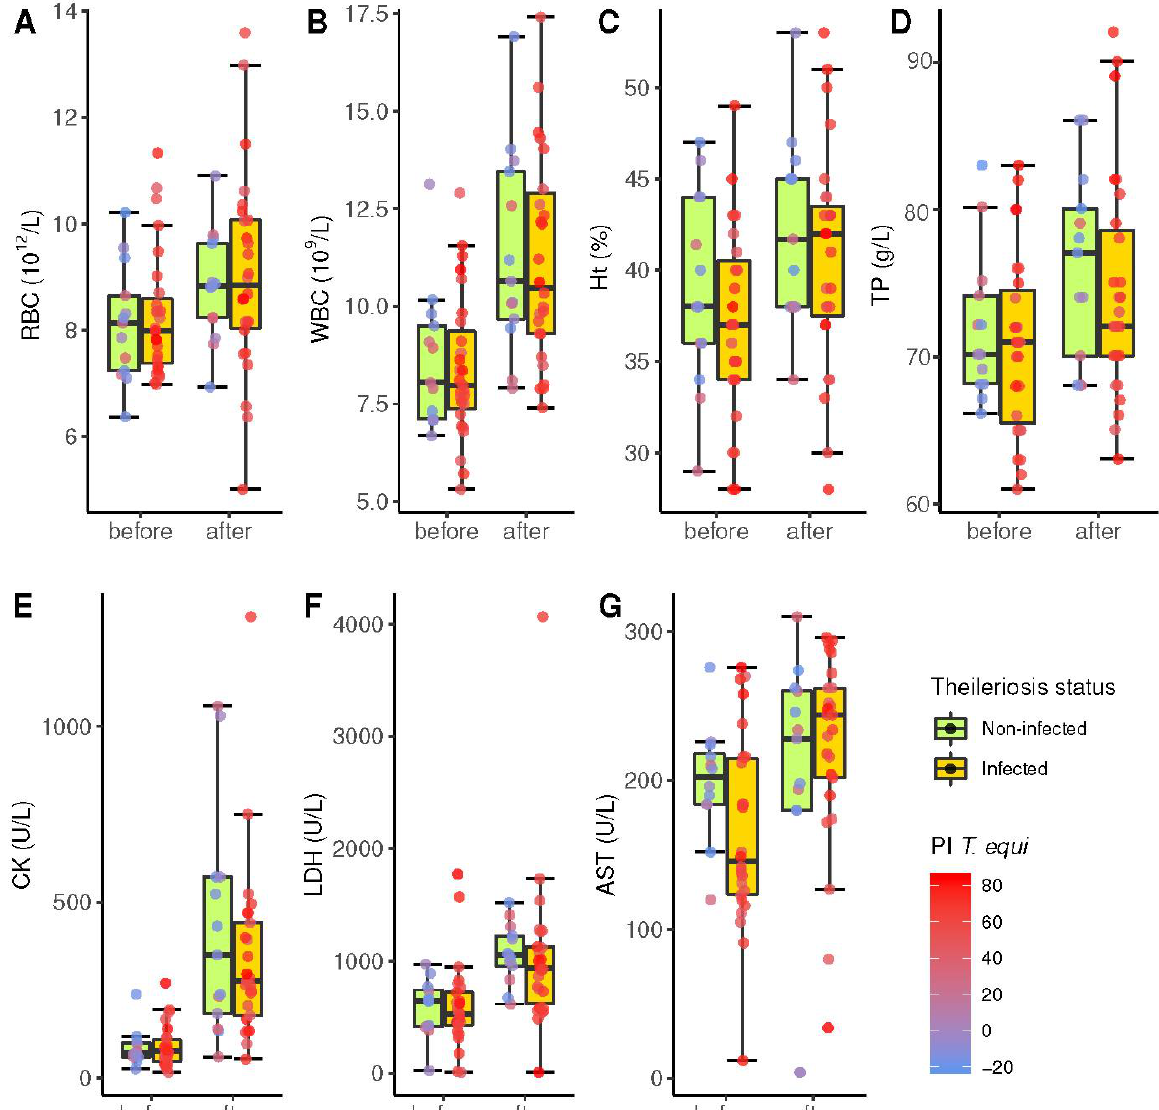
Figure 4. Box and whiskers plot of several hematological and biochemical parameters ( y -axis) before and after the endurance challenge ( x -axis) in 40 horses according to the diagnosis of theileriosis by competitive enzyme-linked immunosorbent assay (cELISA) (orange and green groups, respectively). The horizontal line within each box represents the median of each parameter. Top and bottom box boundaries limit the interquartile range (IQR) between the first and third quartiles. Whiskers show the range of cases within 1.5 times the IQR. The colour of dots represents the percentage of inhibition PI in cELISA according to the colour scale wheaten red (high PI) and blue (low PI). ( A ) RBC: red blood cells; ( B ) WBC: white blood cells; ( C ) Ht: hematocrit value; ( D ) TP: total pro-teins; ( E ) CK: creatinine kinase; ( F ) LDH: lactate de-hydrogenase; ( G ) AST: aspartate